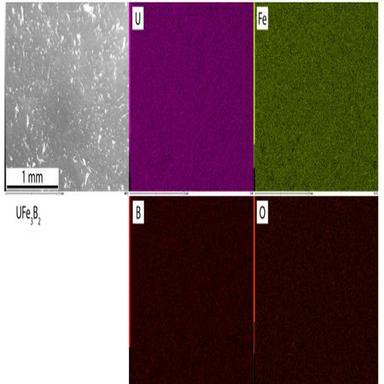
SEM-EDS images of UFe3B2 after annealing.